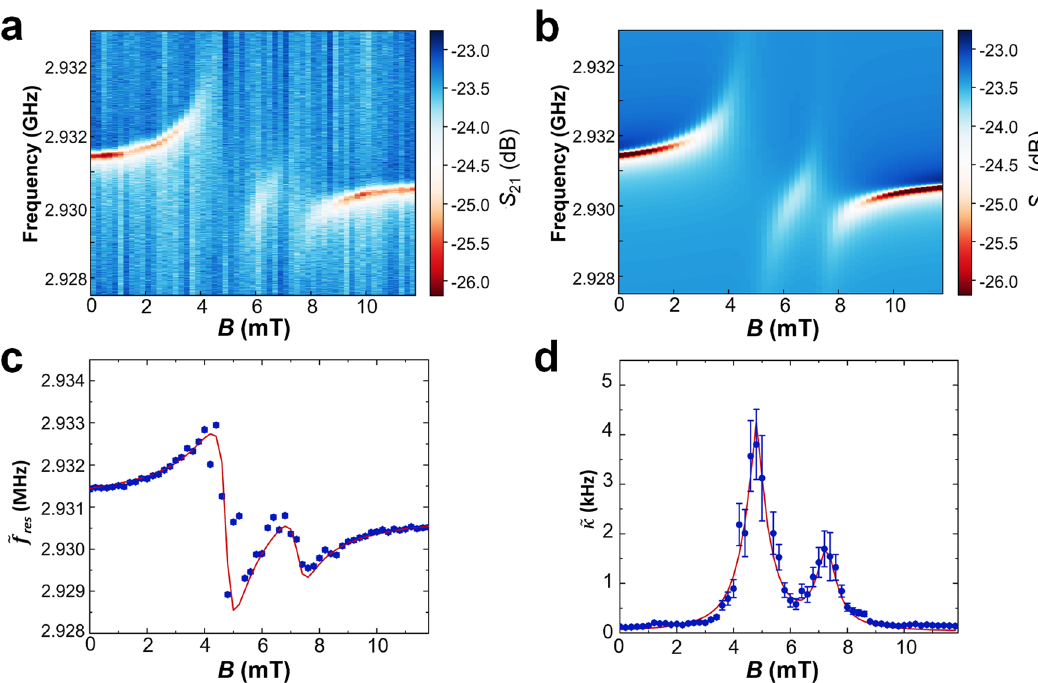
Fig. 3 Coupling cavity photons to the electronic spin. a Color plot of the microwave transmission measured at T = 10 mK near the bare resonance frequency f r = 2.93 GHz of a superconducting lumped-element resonator (LER). The magnetic fi eld brings the splittings between levels 0 and 3 of [ 171 Yb(trensal)] and 0 and 11 of [ 173 Yb(trensal)] into resonance with the cavity photons, leading to the observed avoided crossings. b Optimized simulation of the experimental data shown in a , from which the collective spin – photon coupling and the spin line width are determined. Color scale bars indicate the amplitude of the transmitted signal in relation to the input signal on a logarithmic scale. c Resonance frequency ( ~ f LER system as a function of the magnetic fi eld, extracted from the experimental data (blue dots) and from the fi t (solid red line). Errors have been determined from the Jacobian matrix obtained from the fi ts to Eq.